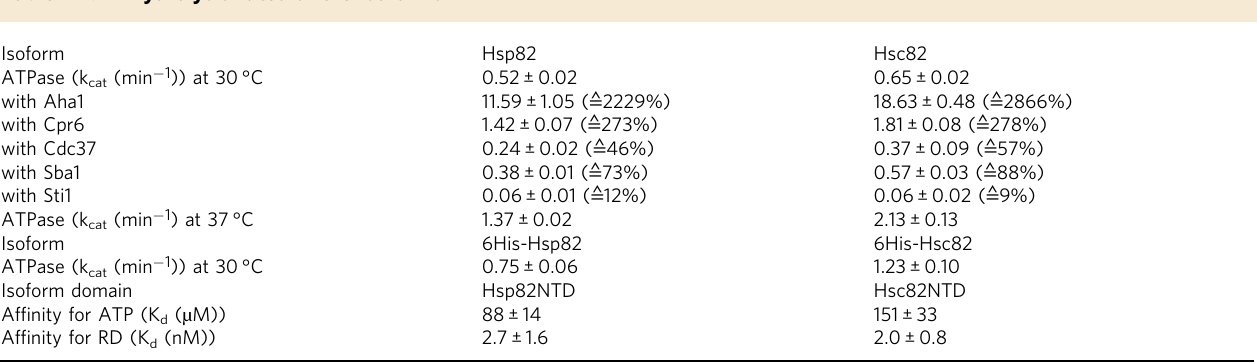
Table 2 ATP hydrolysis rates of the isoforms